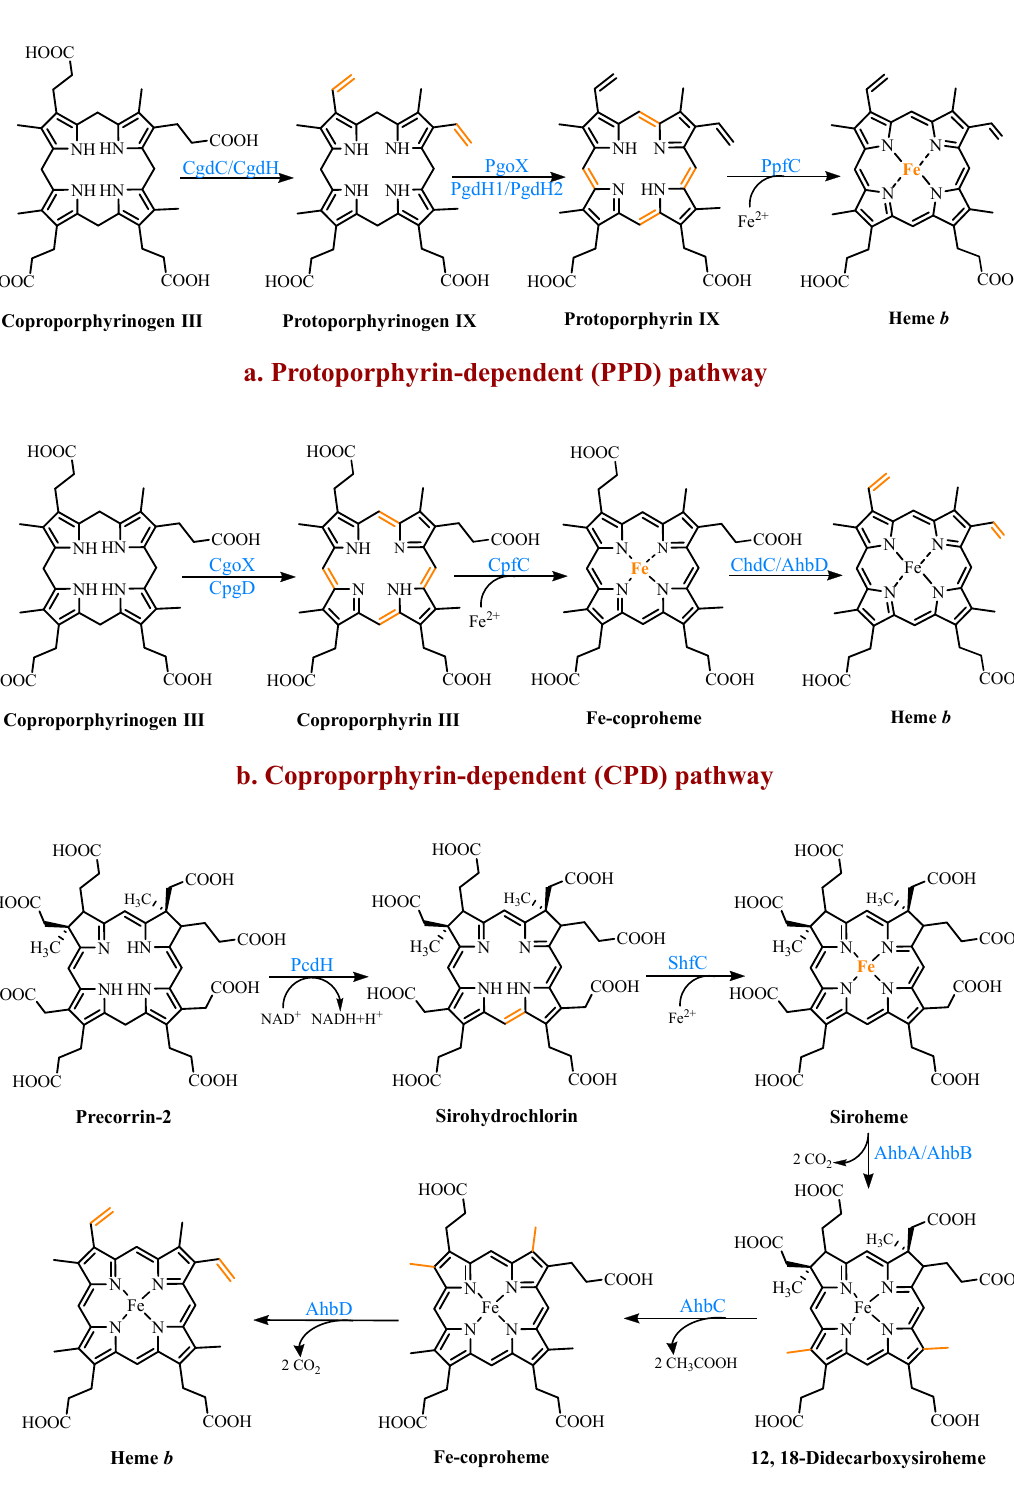
Figure 3. The three known pathways for the heme b biosynthesis. In the protoporphyrin-dependent (PPD) and coproporphyrin-dependent (CPD) pathways, the four methyl groups of heme b are the result of the stepwise decarboxylation of the acetate side chains of uroporphyrinogen Ⅲ (UPG Ⅲ ), with four methyl groups produced at the C2, C7, C12, and C18 positions. The SHD pathway involves the S-adenosyl-L-methionine (SAM)-dependent methylation of the C2 and C7 positions of the tetrapyrrole backbone.